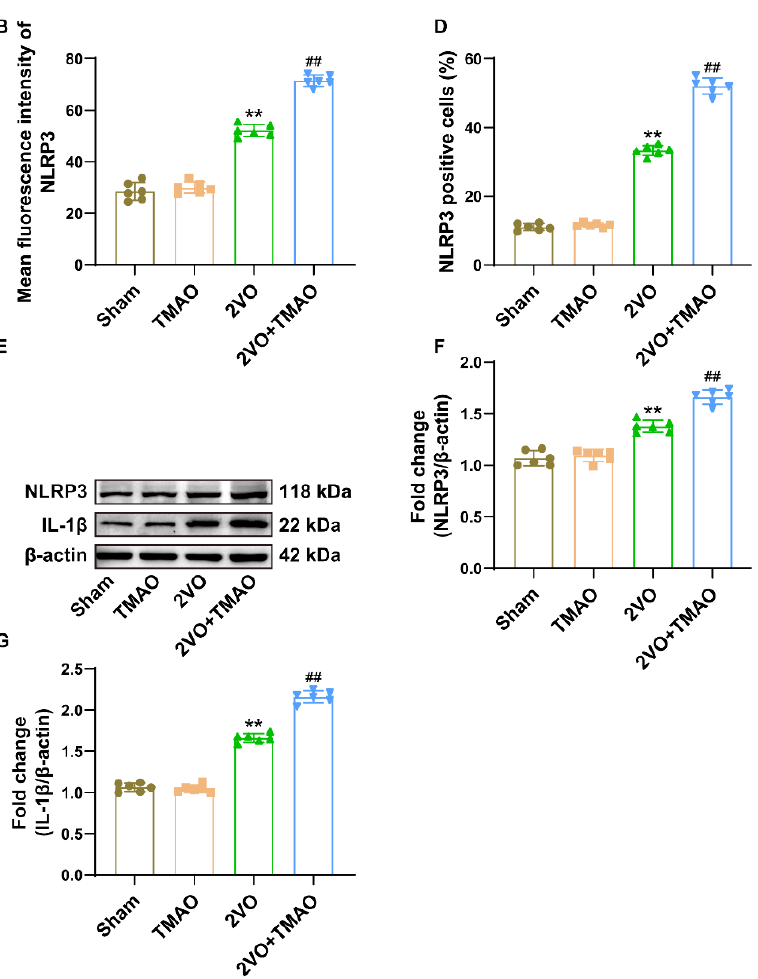
Figure 6. TMAO drove hippocampal NLRP3 inflammasome activation within 2VO rats. ( A ) Im- munostaining displayed colocalization for NeuN (green) and NLRP3 (red) within the hippocampal CA1 area. Nuclei were subjected to DAPI staining. Scale bar, 20 µ m (n = 6). ( B ) Quantification for the mean fluorescence intensity of NLRP3 is shown as a bar chart (n = 6). ( C ) Imaging of the immunohistochemical staining showing the NLRP3 expression within the hippocampal CA1 area. Scale bar, 20 µ m (n = 6). ( D ) Quantification for the NLRP3-positive cells is shown as a bar chart (n = 6). ( E ) Representative bands of NLRP3 and IL-1 β protein expressions within the rat hippocampi across the groups. β -actin served as a loading control (n = 6). Quantification for ( F ) NLRP3 and ( G ) IL-1 β protein expression is shown as a bar chart (n = 6). Datasets reflect the mean ± SD. ** p < 0.01 versus the Sham group; ## p < 0.01 versus the 2VO group.